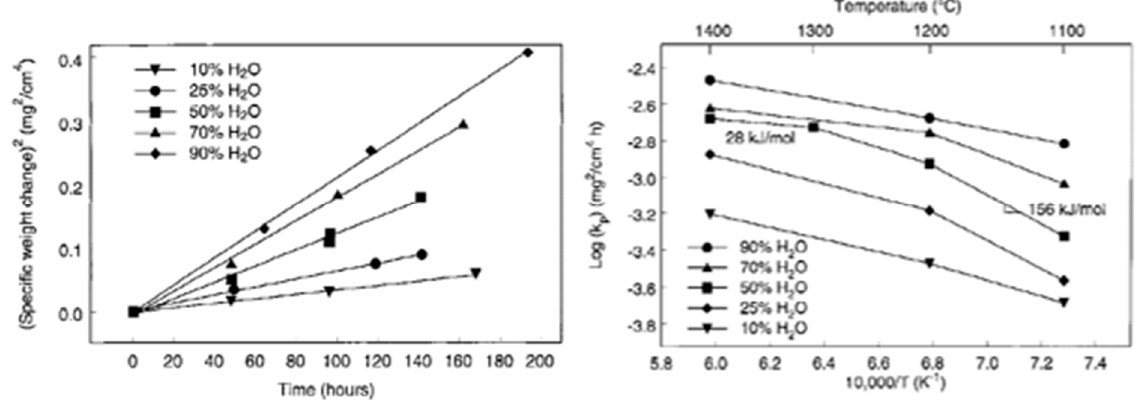
Figure 20. ( Left )—Determination of parabolic rate constants for CVD SiC in H 2 O/O 2 mixtures at a total pressure of 1 atm and a temperature of 1200 °C. ( Right )—Temperature dependence of the parabolic oxidation rate constant for CVD SiC in the temperature range of 1100–1400 °C in various H 2 O/O 2 mixtures. Reprinted with permission from Reference [66]. Copyright 1999 The American Ceramic Society/Wiley.